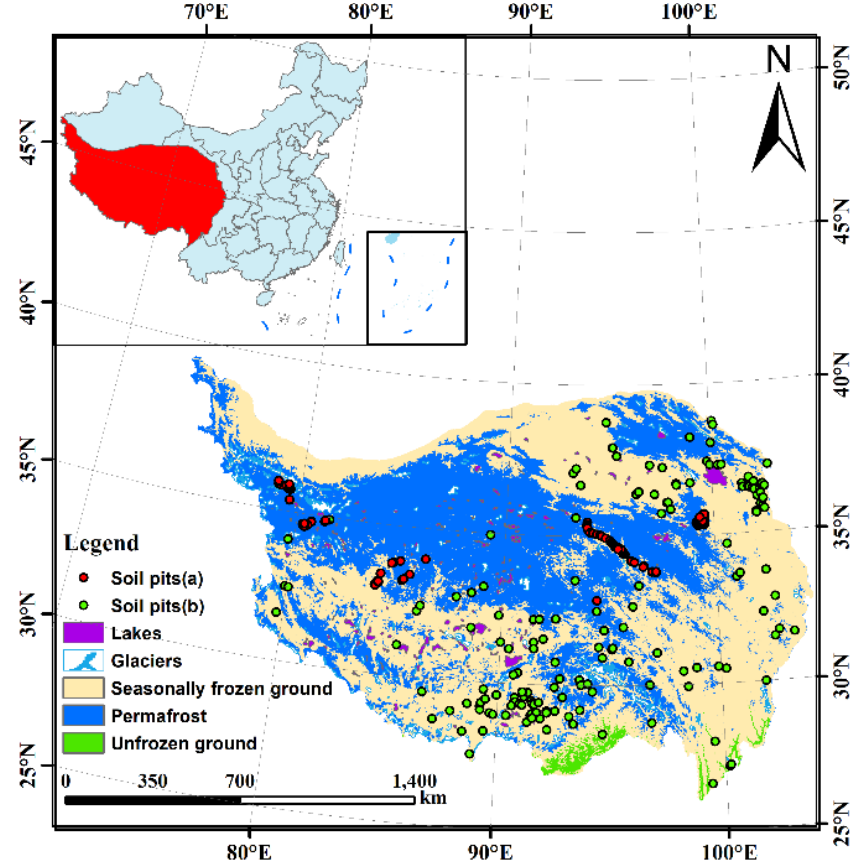
Figure 1. Study area and the distribution of sample sites (the frozen ground map was derived from [18]).